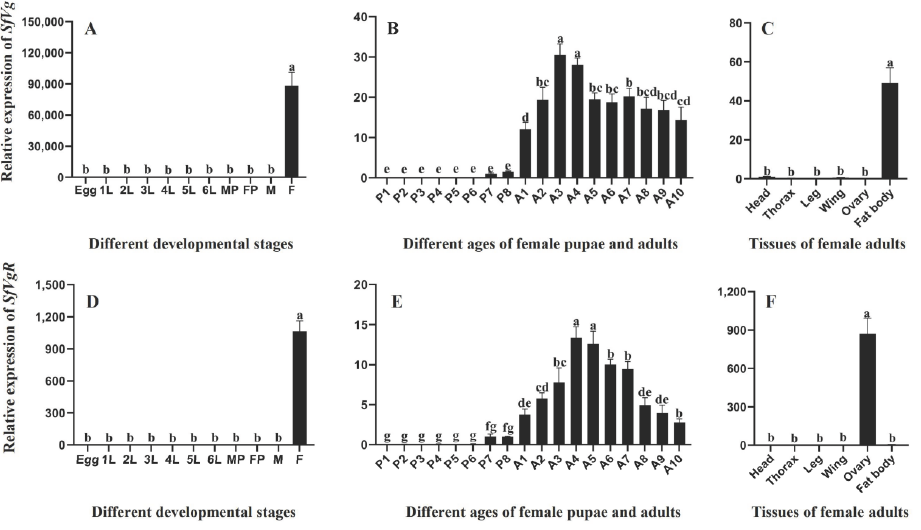
Figure 5 . Developmental and tissue-specific expression patterns of SfVg and SfVgR . Relative